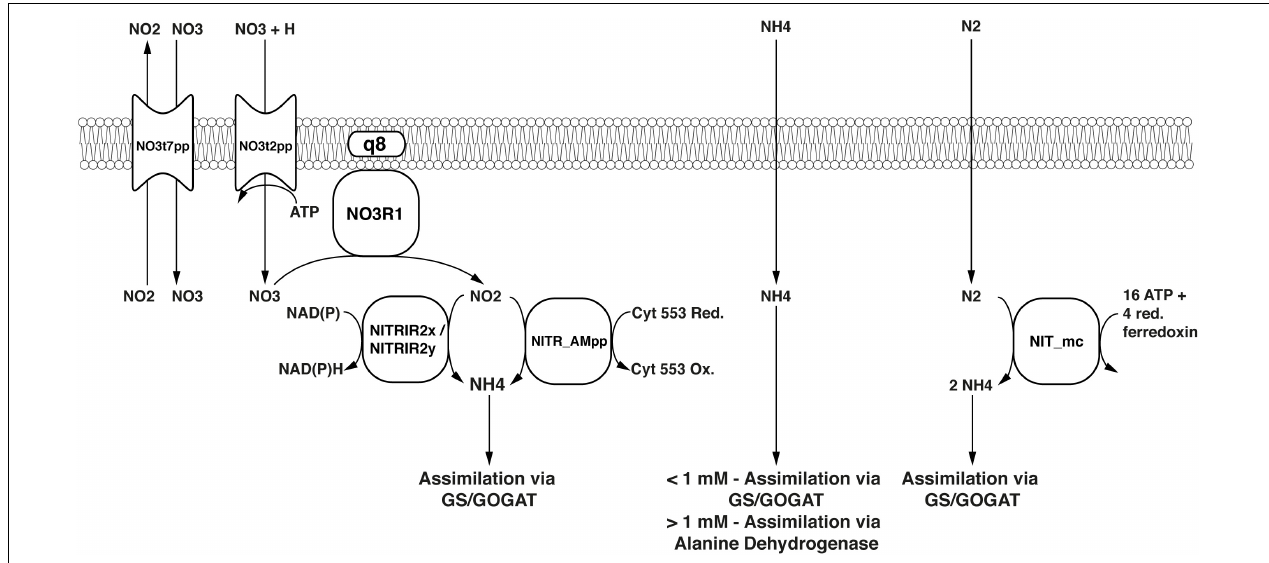
FIGURE 6 | Nitrogen assimilation and fixation pathways represented in the model. Black text in the center of the symbols denotes reaction IDs. Common names are used for metabolites.